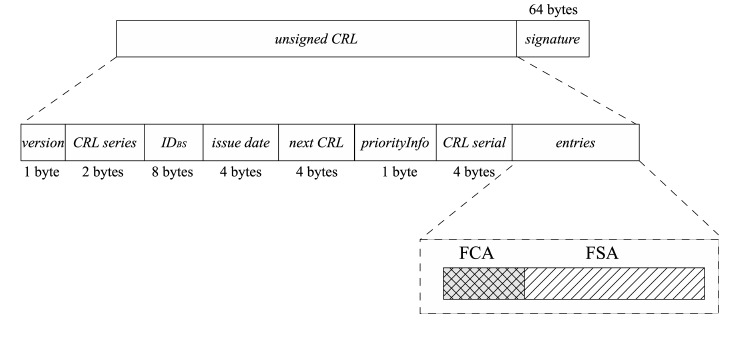
Figure 5. IMF-CRL. Table 1. Notation and explanations for the